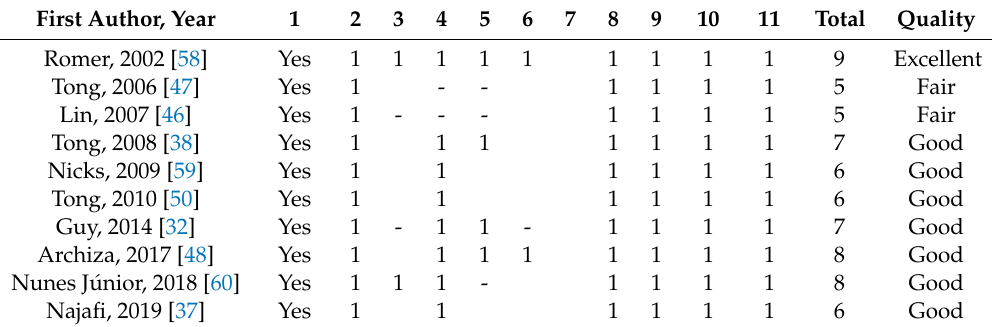
Table 2. PEDro (Physiotherapy Evidence Database) scale quality assessment